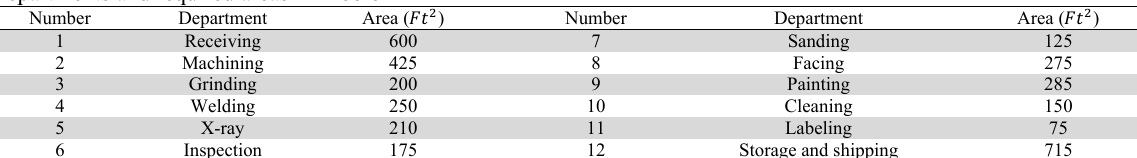
Flow data for Problem 2